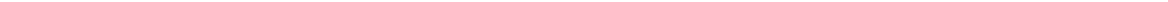
TABLE 1 | The HTL European marine ecosystems, HTL model type, acronym and HTL spatial extent (ranges of latitude and longitude), which was used to extract LTL models outputs (details in Supplementary Table S1 ). Relative changes (%) between the two scenarios (MTFR and REF) of riverine total nitrogen (TN) and total phosphorus (TP) loads estimated by the hydrological model (Grizzetti et al., 2021), and total nitrate (DIN), phosphate (DIP) and primary production (PP) at sea estimated by the hydrodynamic-biogeochemical models (Friedland et al., 2021) for the period